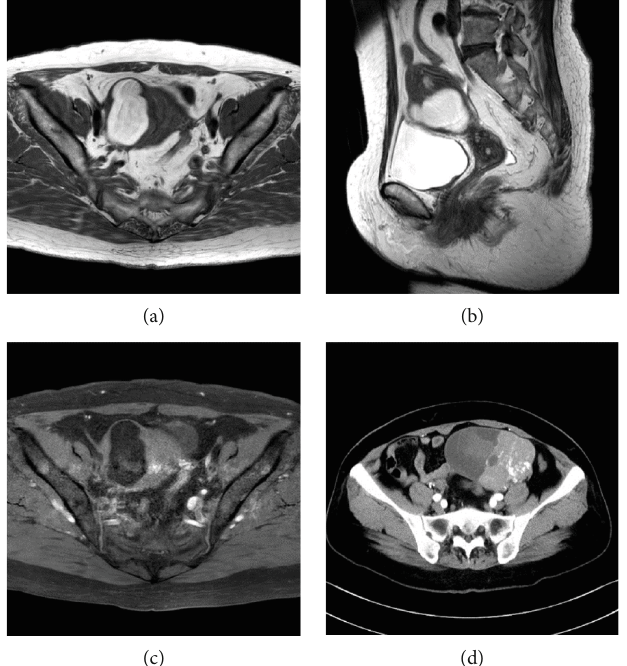
Figure 1: Imaging of the uterine lipoma and the ovarian tumor. The uterine lipoma was examined by MRI: (a) axial T1 weighted imaging (T1WI); (b) sagittal T2 weighted imaging (T2WI); (c) fat suppression T1WI; (d) enhanced CT examination of the left ovarian tumor.